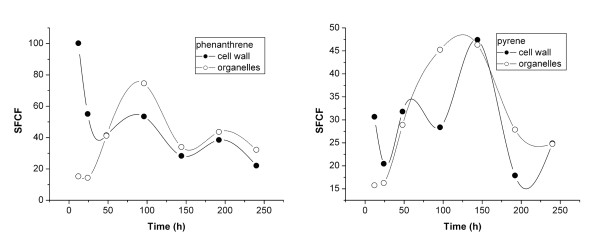
Subcellular fraction concentration factors (SFCF) of phenanthrene (a) and pyrene (b) for ryegrass root uptake as a function of time 0~240 h. SFCF was defined as the ratio of PAH concentration in subcellular fractions including cell wall and organelle to that in cell water-soluble components.